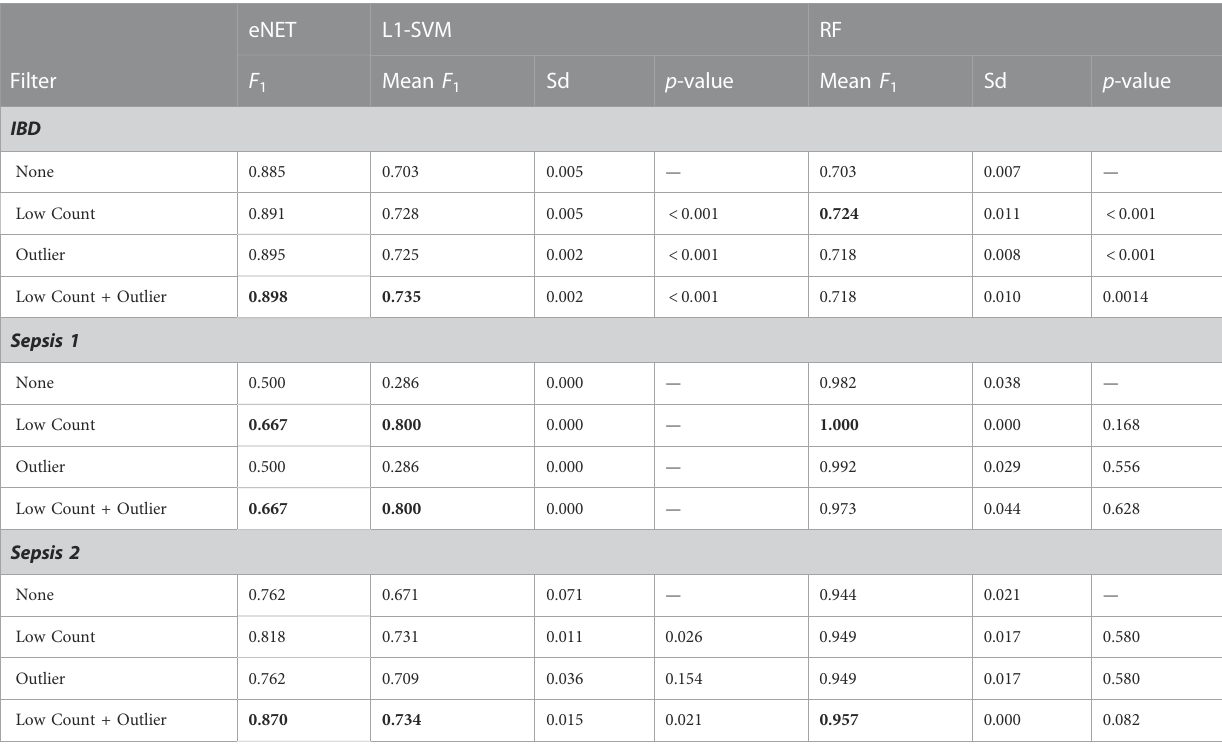
TABLE 2 Gene fi lter impact on classi fi cation performance.